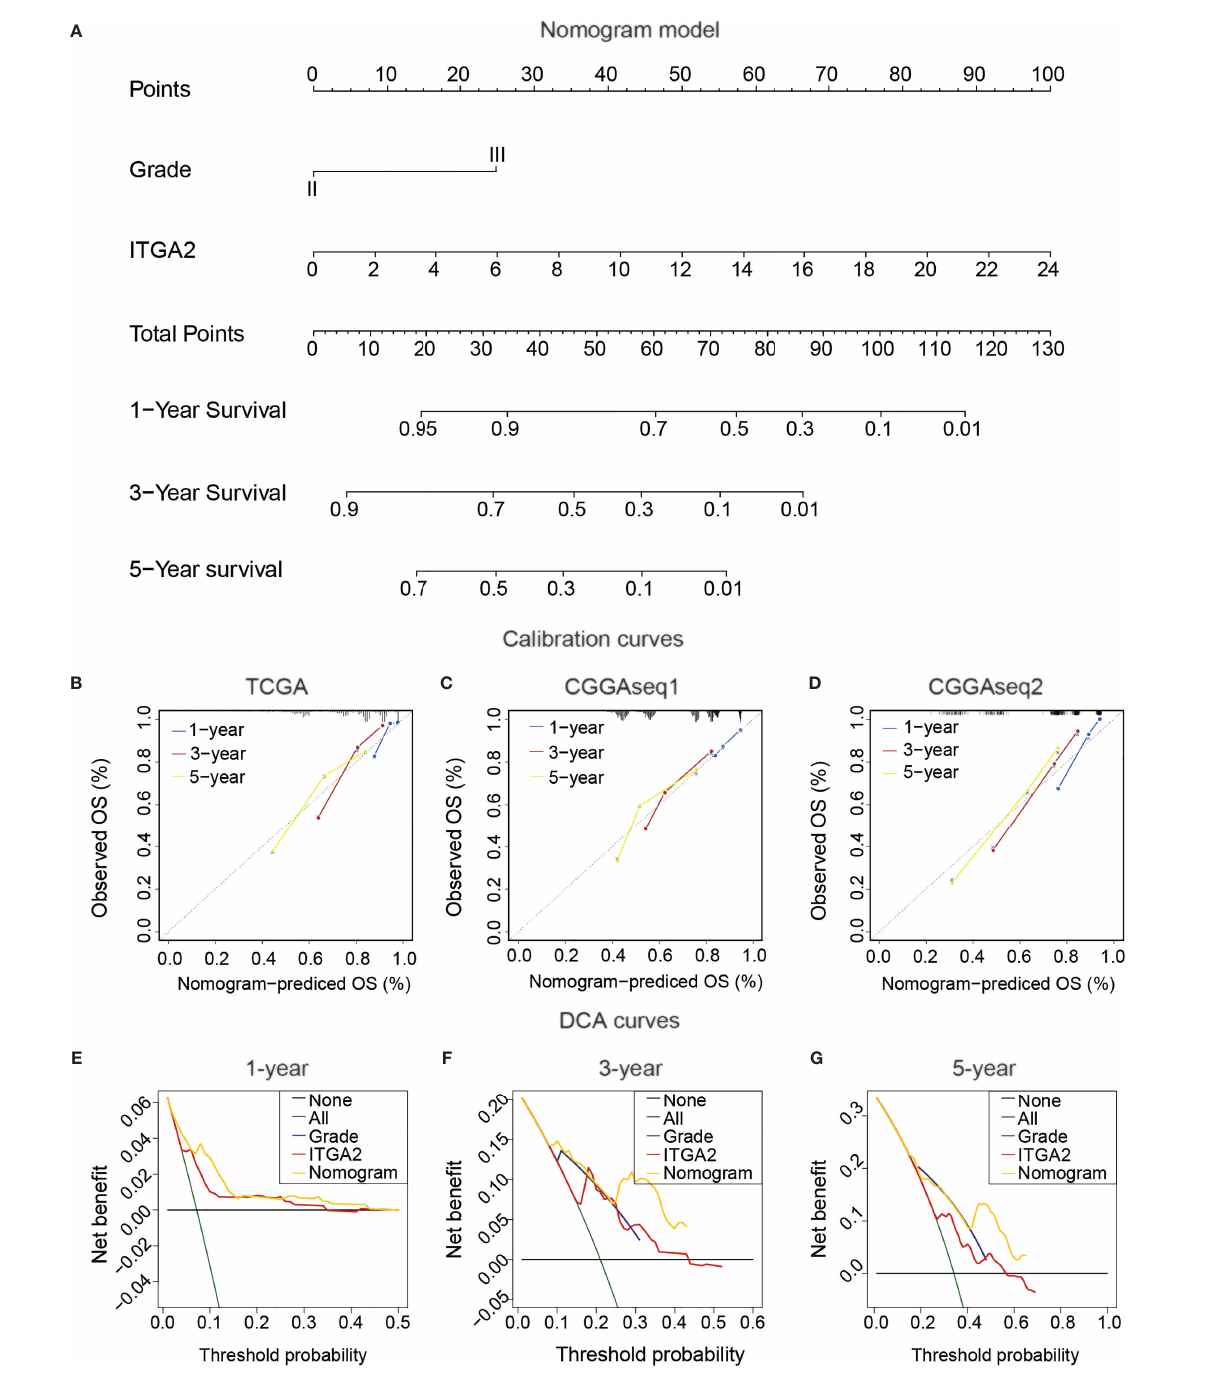
Frontiers in Oncology |